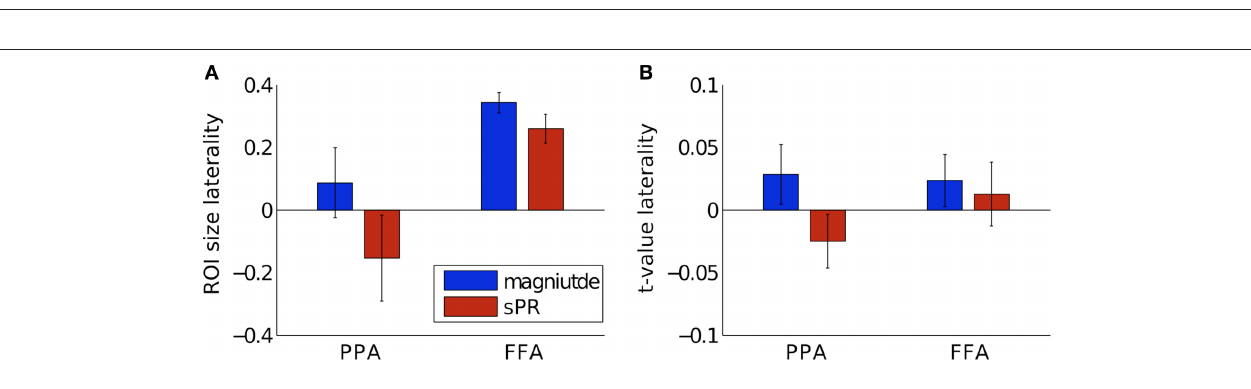
FIGURE 11 | Hemisphere laterality with and without large vein suppression. Positive values indicate right hemisphere lateralization while negative values indicate left hemisphere lateralization. (A) Size laterality measured as the ratio of hemispheric difference to hemispheric sum of ROI size. Large vein suppression significantly reduces right hemisphere size laterality in PPA [ p < 0.02 , paired- T (3) ] but only to a marginally significantly degree in FFA ( p = 0.08 ). (B) fSNR laterality measured as the ratio of hemispheric difference to hemispheric sum of mean ROI t -value. Large vein suppression significantly reduces right hemisphere fSNR laterality in PPA ( p < 0.05 ) but not significantly in FFA ( p = 0.18 ). Error bars are SEM across